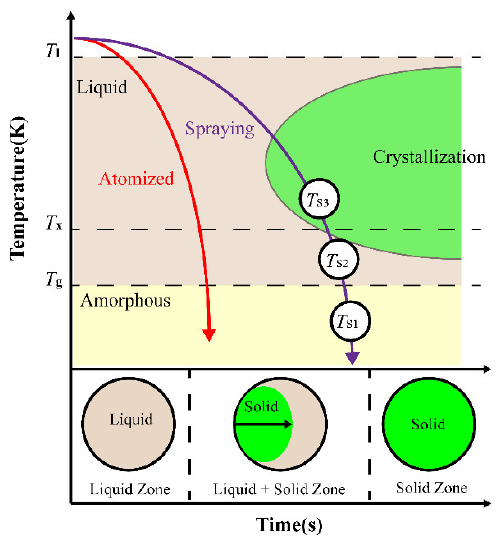
Figure 2. Schematic time–temperature transformation ( TTT ) curve for the (Cu 43 Zr 47 Al 7 Ag 3 ) 99.5 Co 0.5 amorphous powder and the temperatures ( T S1 , T S2 , and T S3 ) selected for HVAF spray. (Note: T S1 < T g , T g < T S2 < T x , and T x < T S3 .)